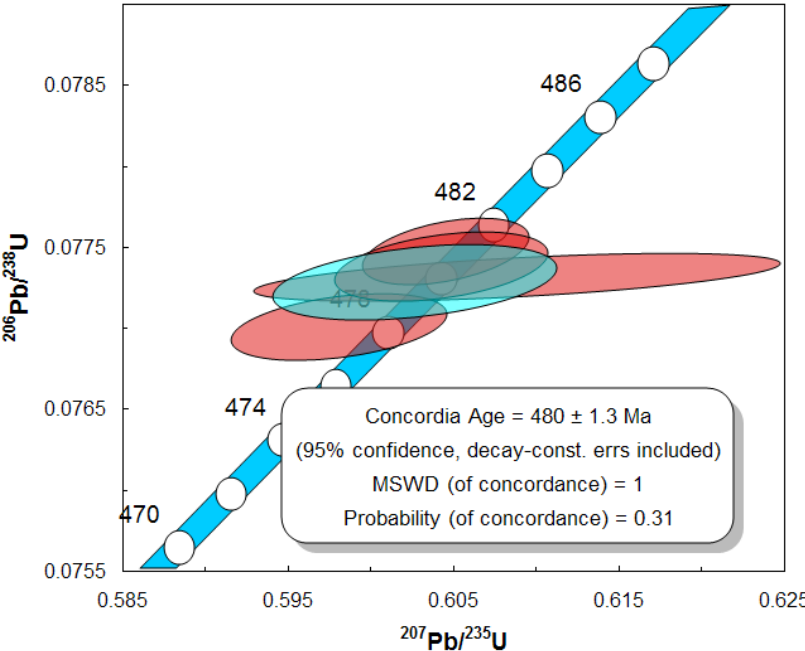
Figure 12. Concordia diagram for cassiterite from the Yaroslavskoe deposit (sample DV-1).